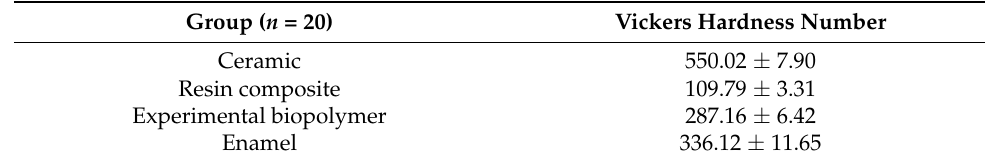
Table 3. Mean ± SD of microhardness value (Vickers hardness number; VHN) for all groups.